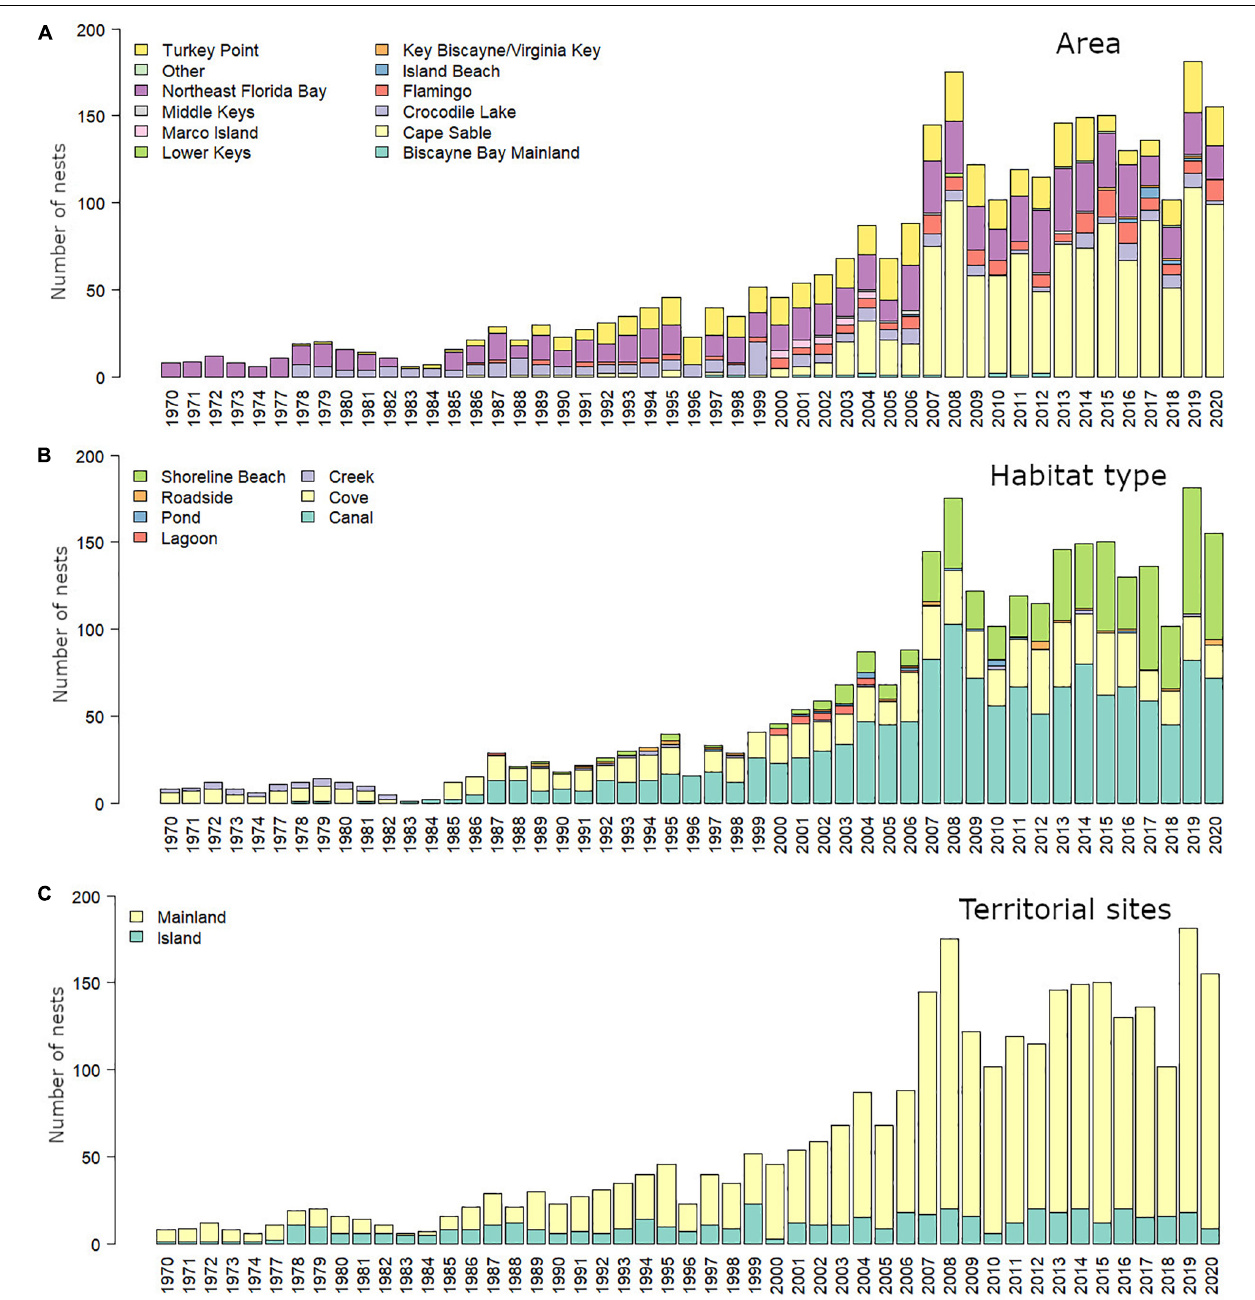
FIGURE 2 | Number of American crocodile ( Crocodylus acutus ) nests reported in South Florida, United States, from1970 to 2020. Nesting has been increasing across main areas (A) and habitat types (B) including manmade habitats. There has also been a greater increase in nest on mainland sites than island sites (C) likely related with space availability (see